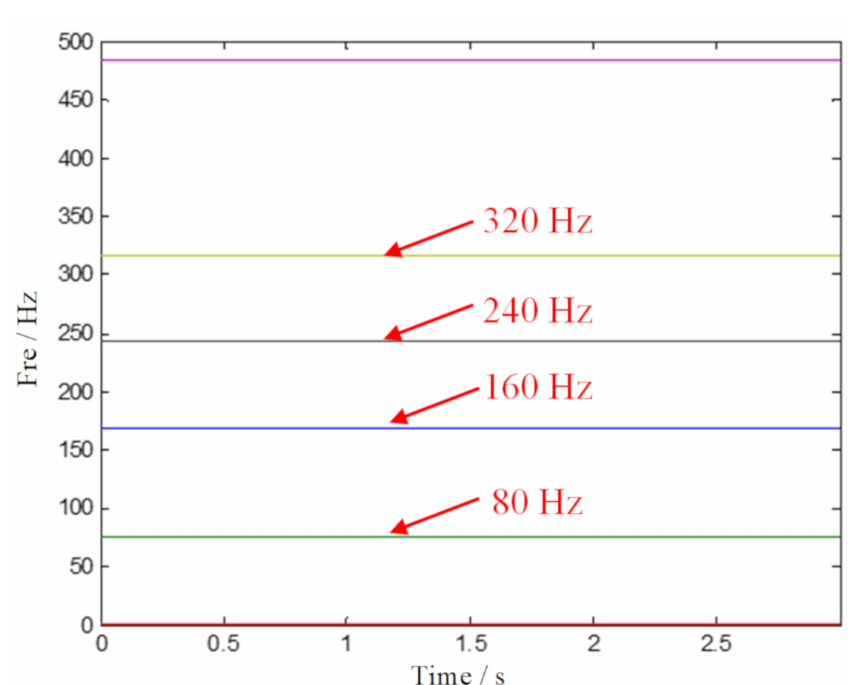
Figure 12. The multiple ridge identification by the proposed ISECT